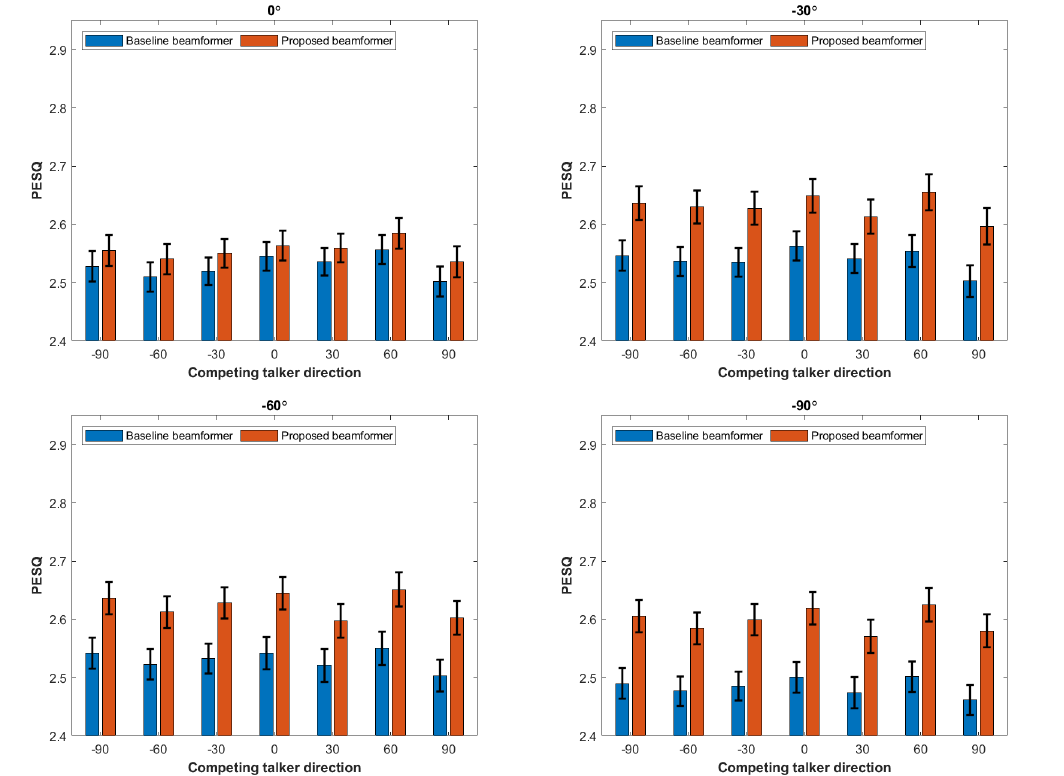
Figure 8. Average PESQ scores and 95% confidence intervals for the outputs of the baseline and proposed beamformers depending on the azimuths of the desired source and a competing talker with an RT60 of 500